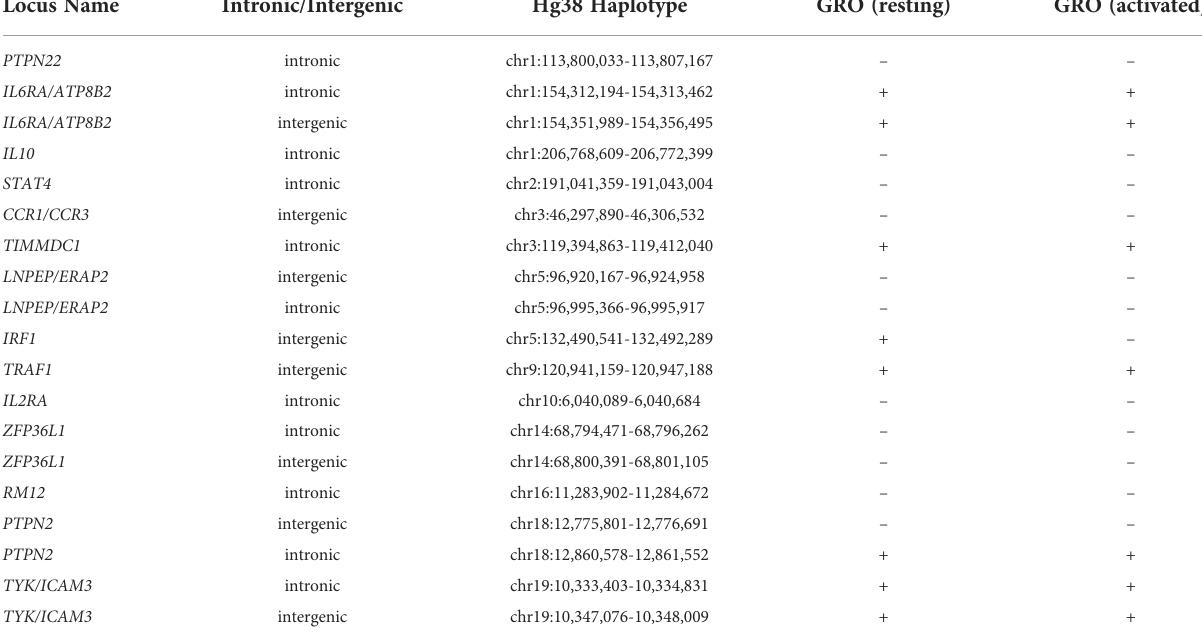
TABLE 6 GROseq peaks that overlap SNPs detected on MPRA in